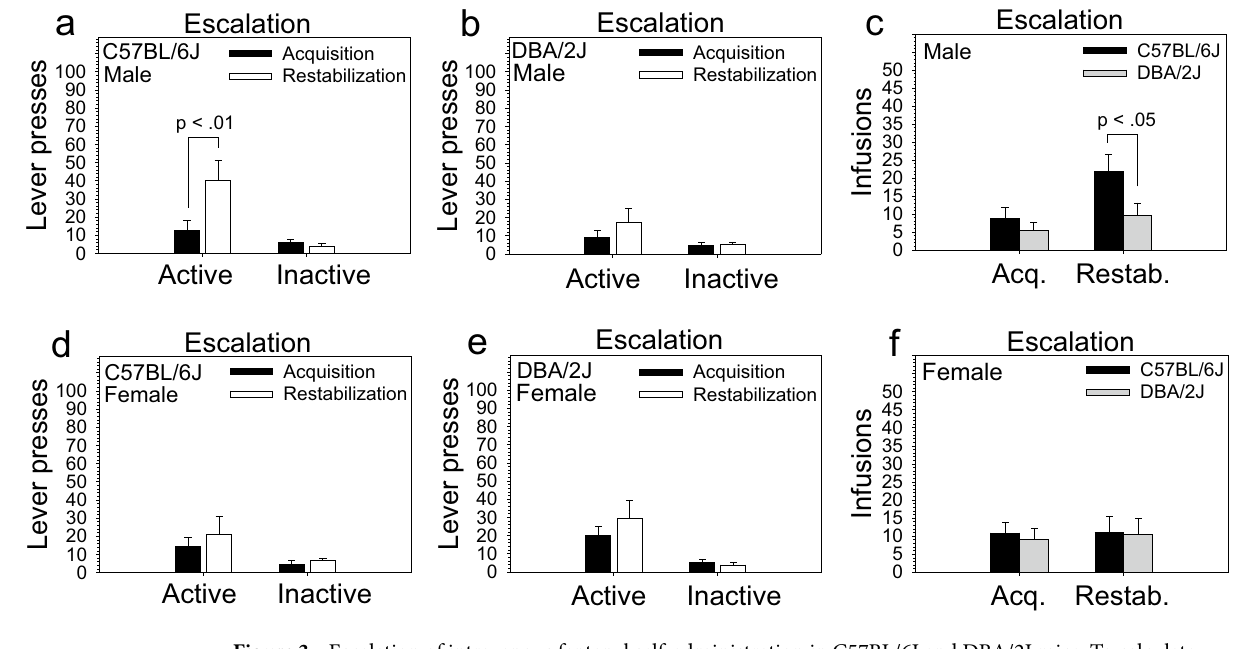
Figure 3. Escalation of intravenous fentanyl self-administration in C57BL/6J and DBA/2J mice. To calculate escalation, we compared performance on the acquisition stage with performance on the restabilization stage that immediately followed the dose–response curve; both stages used the 56 µg/kg/infusion dose. ( a , b , d , e ) Male C57BL/6J mice, but not other subgroups, significantly escalated active lever pressing ( p < .01), but not inactive lever pressing, on the restabilization stage relative to the acquisition stage. ( c , f ) Moreover, male C57BL/6J mice intravenously self-administered significantly more fentanyl on the restabilization stage ( p < .05), but not acquisition stage, relative to male DBA/2J mice; this difference was not observed in females. Data are presented as the mean ± S.E.M.